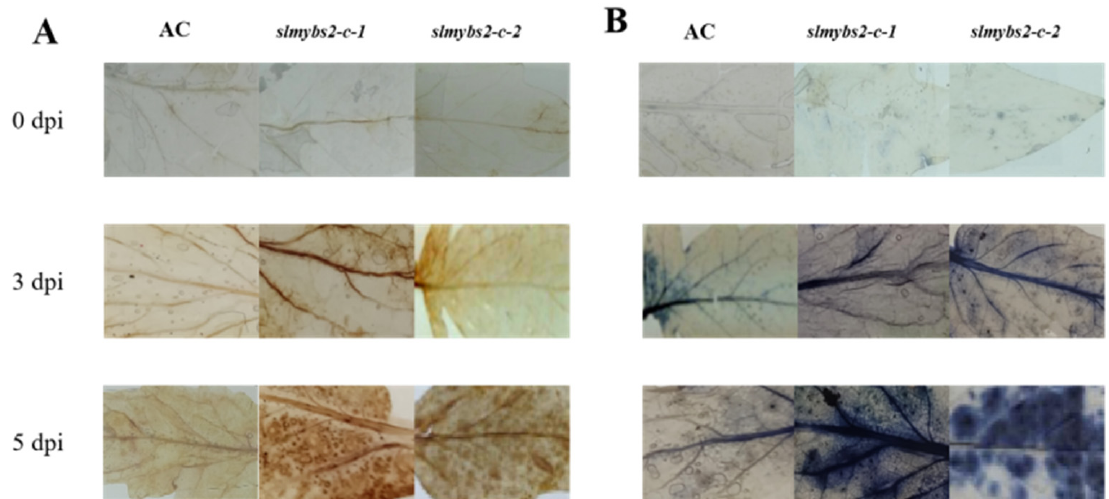
Figure 5. Accumulation of H 2 O 2 ( A ) and O 2 − ( B ) in AC and slmybs2-c -plants after inoculation with P. infestans. ( A ) Accumulation of H 2 O 2 . Tomato leaves were stained with DAB at 0, 3, and 5 dpi. ( B )